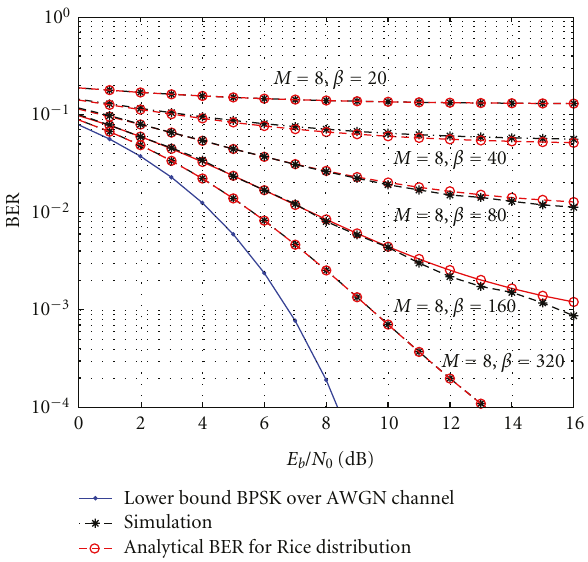
Figure 6: Zoom of the PDFs in the Figure 5. Figure 7: Simulated BER and analytical BER expression for Rice distribution for M = 8 and β =